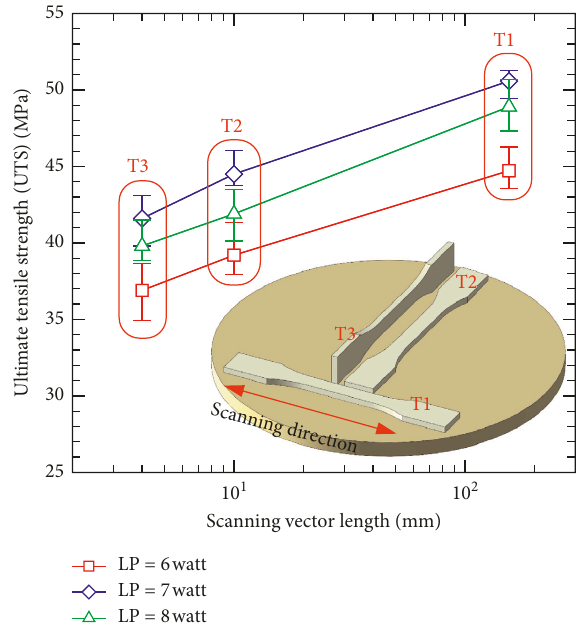
Figure 5: Effect of scanning vector length on ultimate tensile strength of PA12/white cement composite.